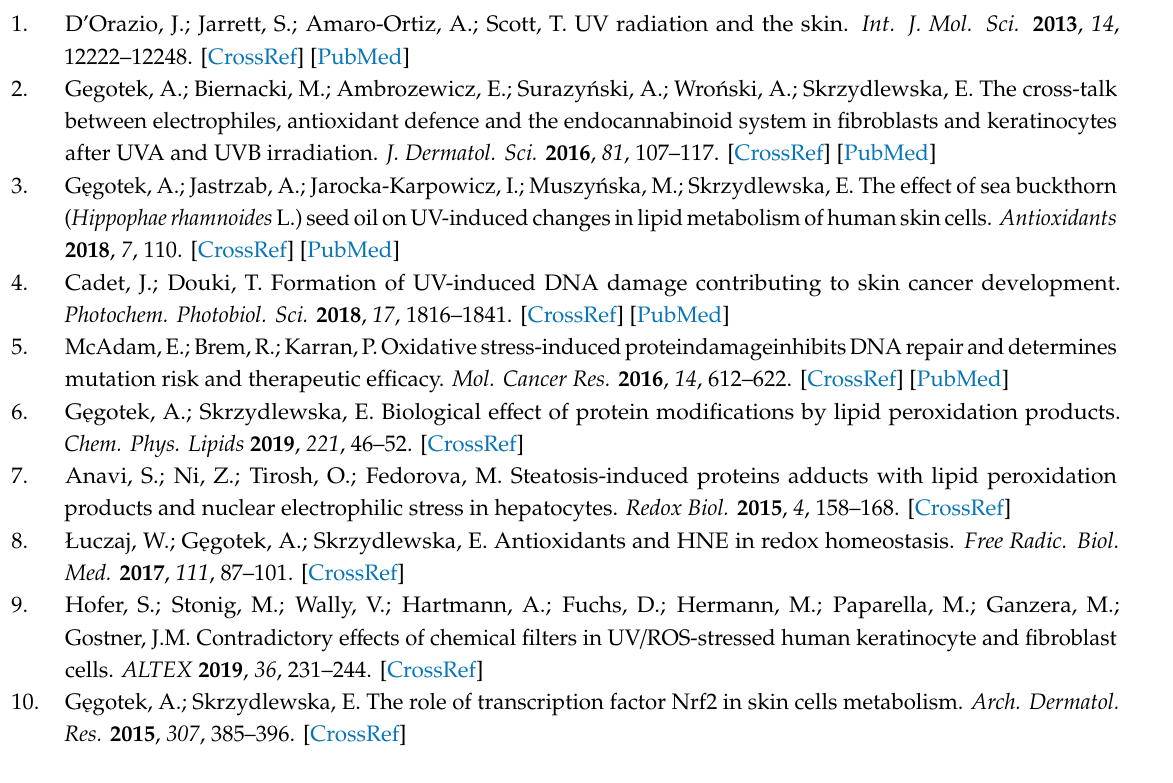
Table S1: List of proteins indicated in the 3D cultured fibroblasts exposed to UVB irradiation (200 mJ / cm2) and treated with ascorbic acid [100 µ M] or / and rutin [25 µ